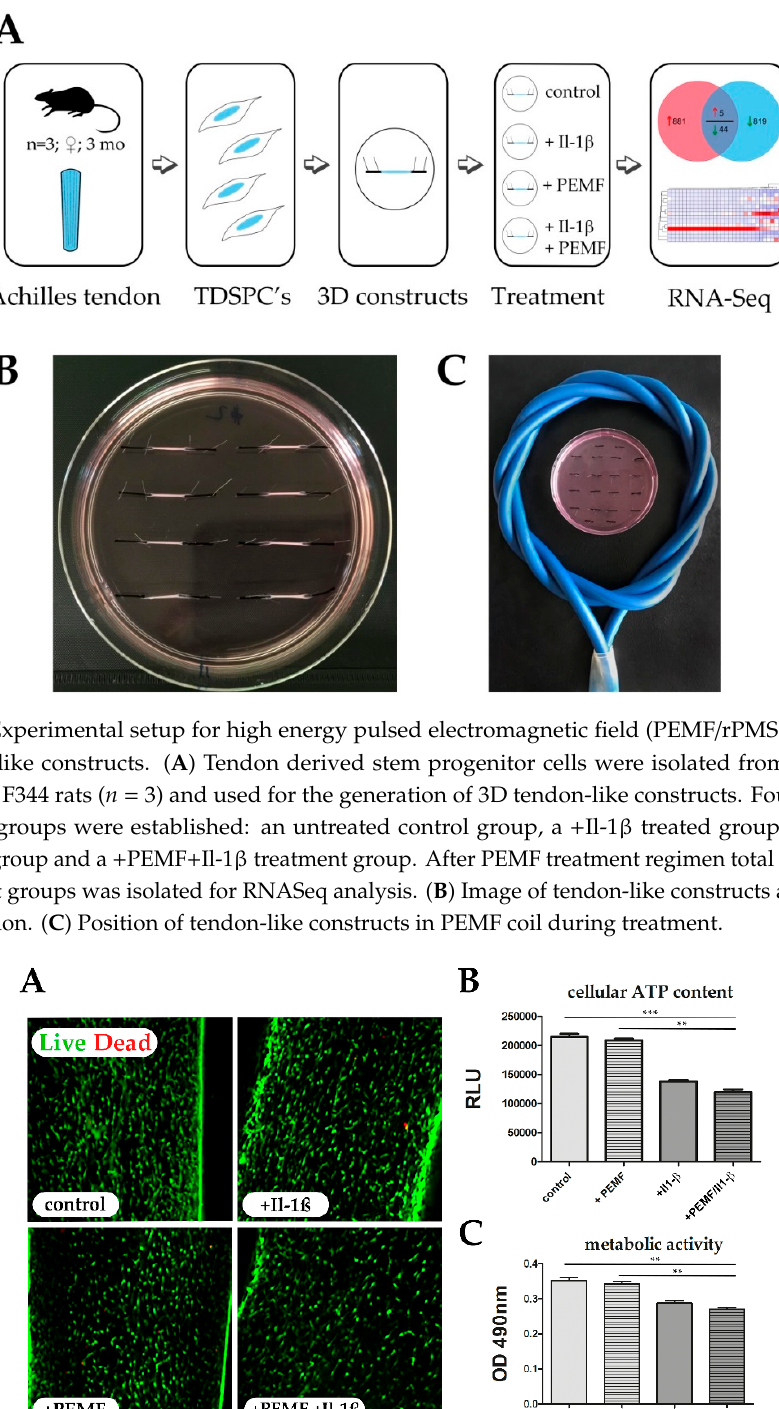
Figure 2. Cell viability and cellular metabolic activity of treated tendon-like constructs ( A ) Live / Dead Assay showing viable cells in green and dead cells in red. ( B ) Total cellular ATP content after + Il-1 β and + PEMF + Il-1 β treatment is significantly diminished compared to untreated control or + PEMF treatment alone. ( C ) MTT Assay was performed for determination of metabolic activity of TDSPCs, showing a significant decrease in metabolic activity in the + Il-1 β and + PEMF + Il-1 β treatment groups. ** p < 0.01, *** p <